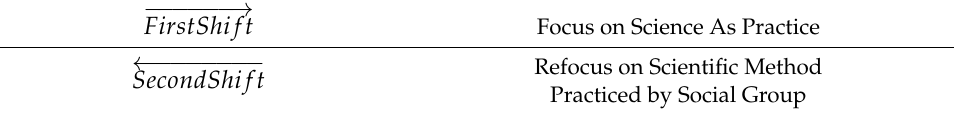
Table 1. Longino’s Two Shifts of Perspective To See How Scientific Method is